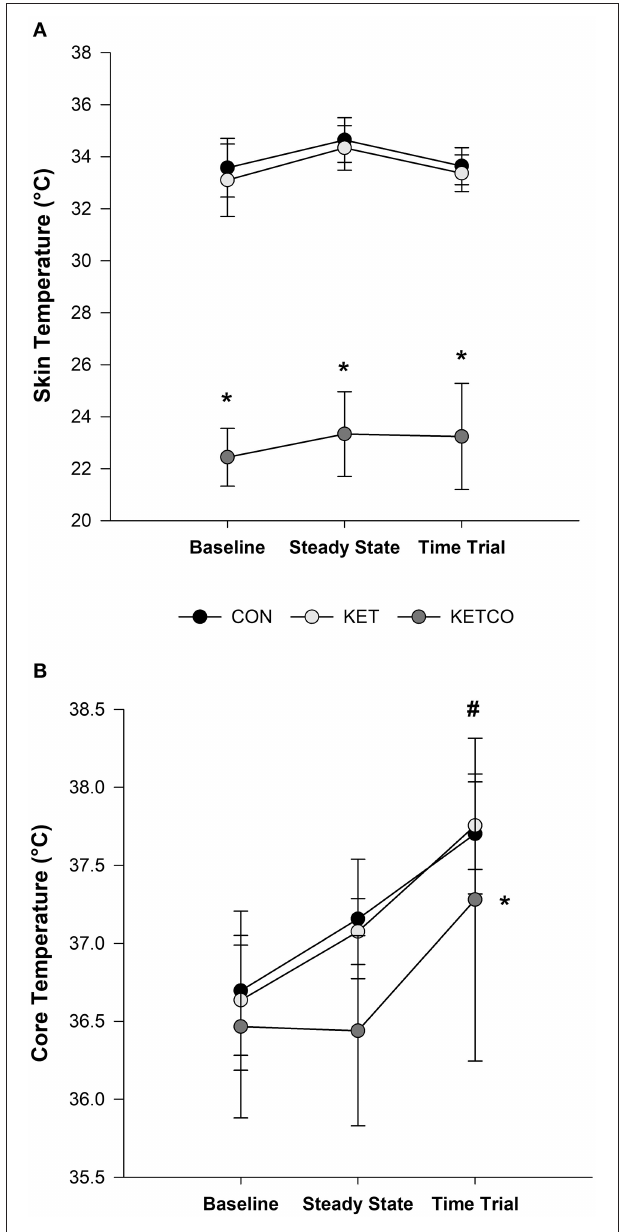
FIGURE 1 | (A) Mean skin temperature ( T sk ), and (B) mean core temperature (T c ) at BL and during SS and TT exercises for each experimental condition. *Significantly different from CON and KET conditions, # significantly different from BL and